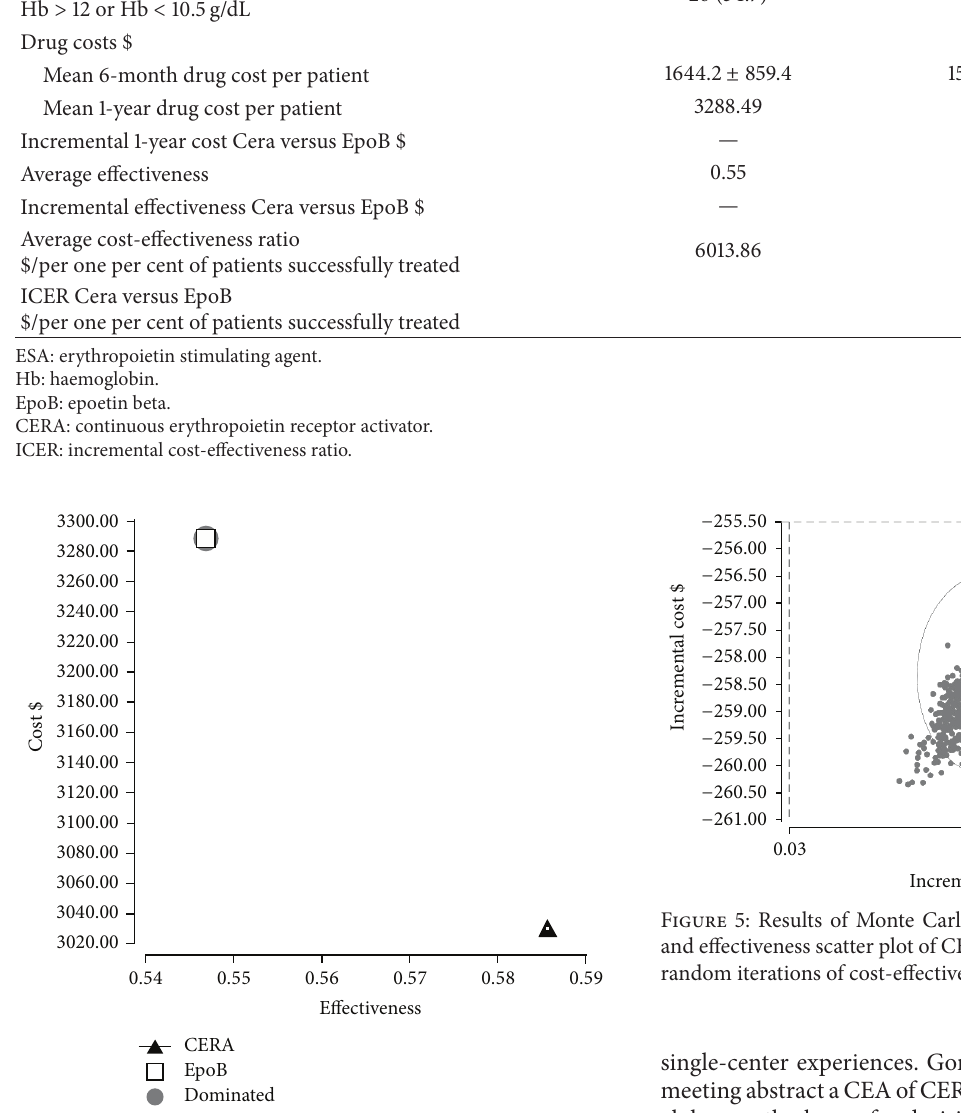
Figure 4: Cost-effectiveness diagram. EpoB is dominated by CERA since it is more costly and less effective.